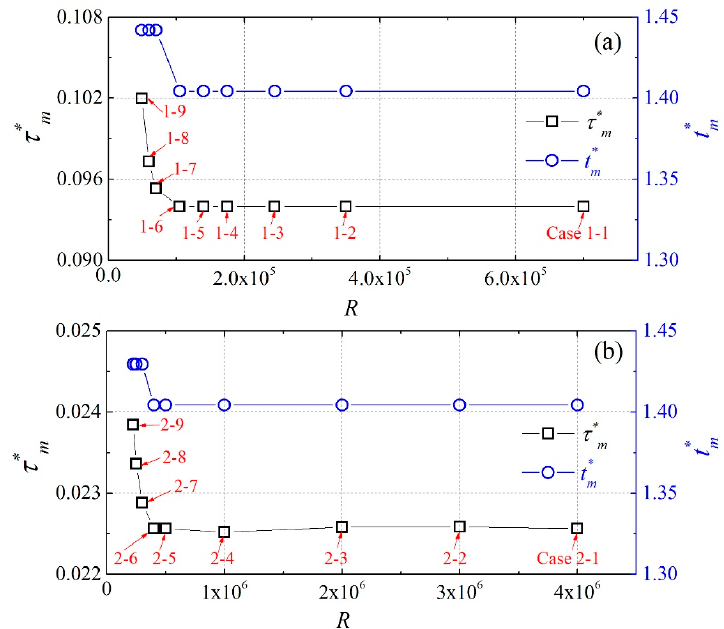
Figure 5. Transitional behavior of maximum bottom shear stress and its appearance time. ( a ) Re = 3.51 × 10 6 , ( b ) Re = 1.99 × 10 7